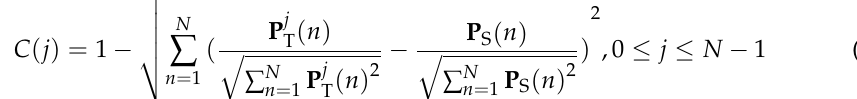
, 𝐏 , re- (cid:2904) (cid:2903)